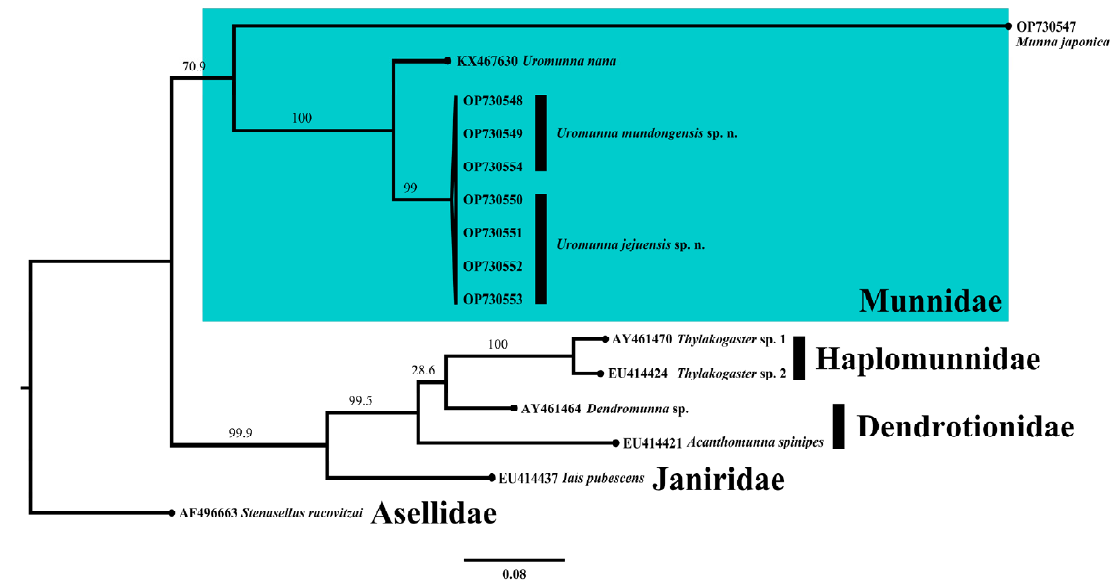
Figure 16. Maximum-likelihood phylogram of 18S sequences showing the phylogenetic relationships of U. mundongensis and U. jejuensis sp. n. with related groups. The clade in the green rectangle indicates Munnidae. Scale shows substitutions per site. Numbers above the branches represent bootstrap support.